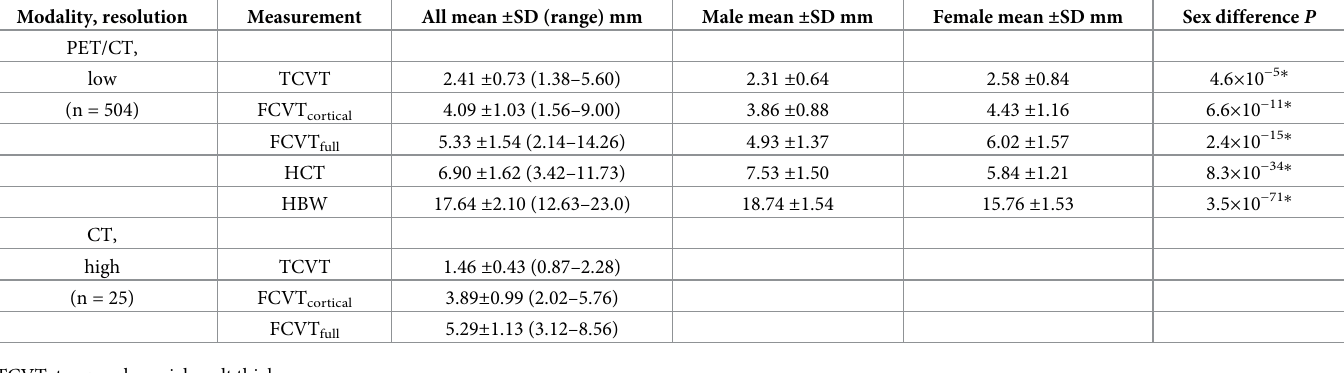
Table 1. Summary of